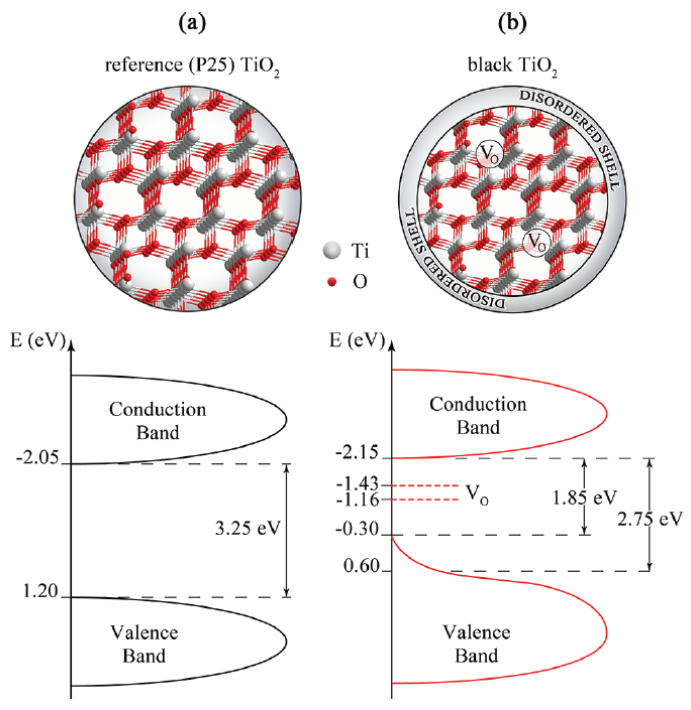
Figure 4. The comparison between the structure and density of states (DOS) of ( a ) P25 TiO 2 and ( b ) black TiO 2 . Reprinted with permission from [30]. Copyright 2012, American Chemical Society.